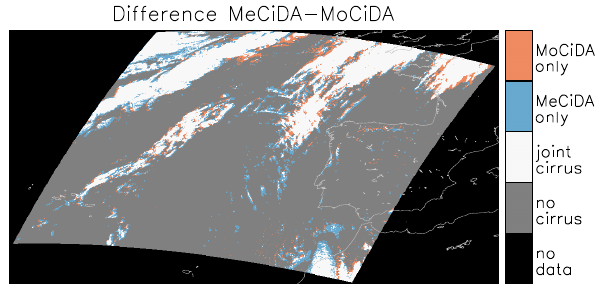
Fig. 8. Sample cirrus products for 11 January 2009, 12:00UTC, west of Spain/Portugal. Difference between the MeCiDA2 and Mo- CiDA2 cirrus masks: red and blue identify cirrus pixels that are de- tected by MeCiDA2 or MoCiDA2 alone, white means cirrus pixels that are detected by both algorithms, while grey corresponds to cir- rus free